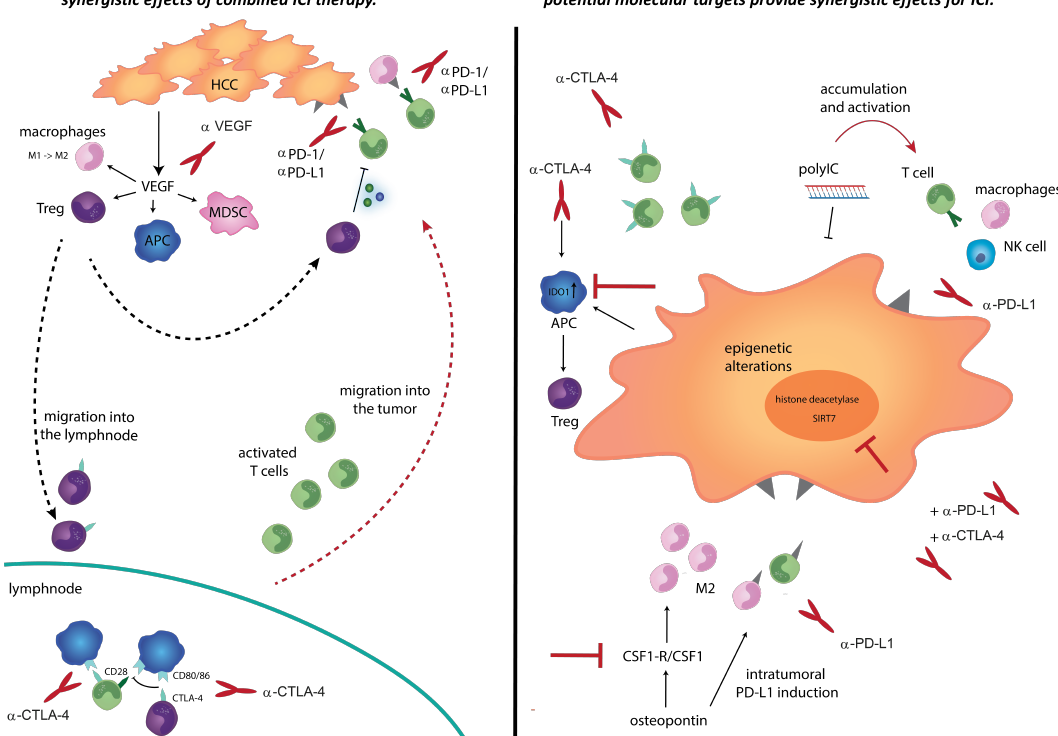
Figure 2. Translational consideration to overcome therapy resistance. Therapeutic approaches for sensitization to immunotherapy. Left panel : Anti-CTLA-4 or anti-angiogenic therapy increases recruitment and migration of activated T cells into the tumor. Anti-PD-1 / anti PD-L1 therapy enhances cytolytic activity of T cells. Right panel : Anti-CTLA-4 treatment induced IDO1 expression in dendritic cells (DC). Indoleamine 2,3-dioxygenase 1 (IDO1) leads to activation of T regs and causes resistance to anti-CTLA-4 therapy, while blocking of IDO could interrupt this mechanism of resistance. PolyIC inhibits tumor growth and leads to an accumulation and activation of immune cell subsets, whereas anti-PD-L1 therapy could provide synergistic e ff ects. Osteopontin induces M2 migration into the tumor as well as PD-L1 induction. Targeted therapy of CSF1 in combination with anti-PD-L1 therapy might provide synergistic e ff ects. Epigenetic regulations as synergistic e ff ect for ICI